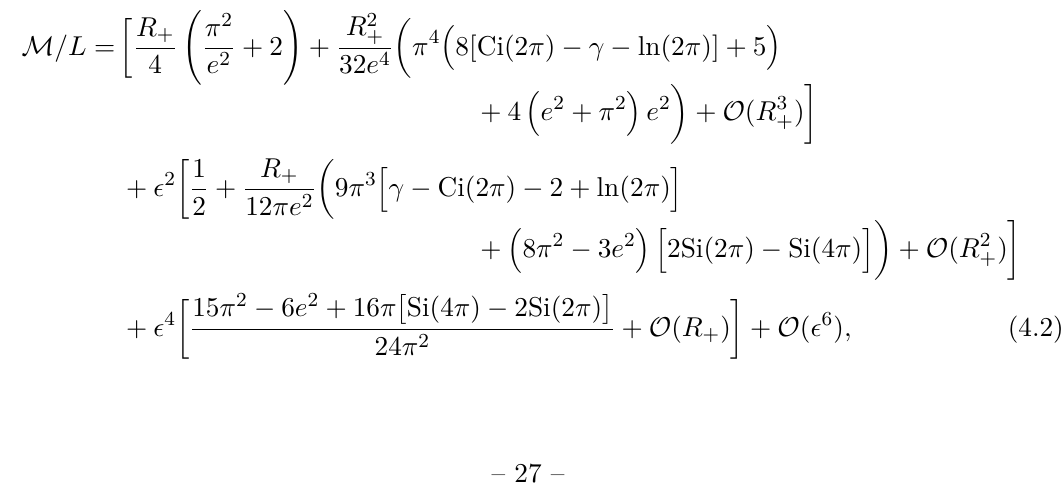
Figure 11 . Comparing the exact numerical results (blue circles) with the perturbative analytical predictions (4.2)–(4.3) (green curve) for a family of black holes with constant R As expected, the perturbative analysis matches the exact results only for small R close to the origin and in the neighbourhood of the merger, yellow diamond, line which has (cid:15) = 0 ). That is to say, for the R = 0 . 05 family shown, good agreement occurs for small Q , say Q . 0 . 2 +